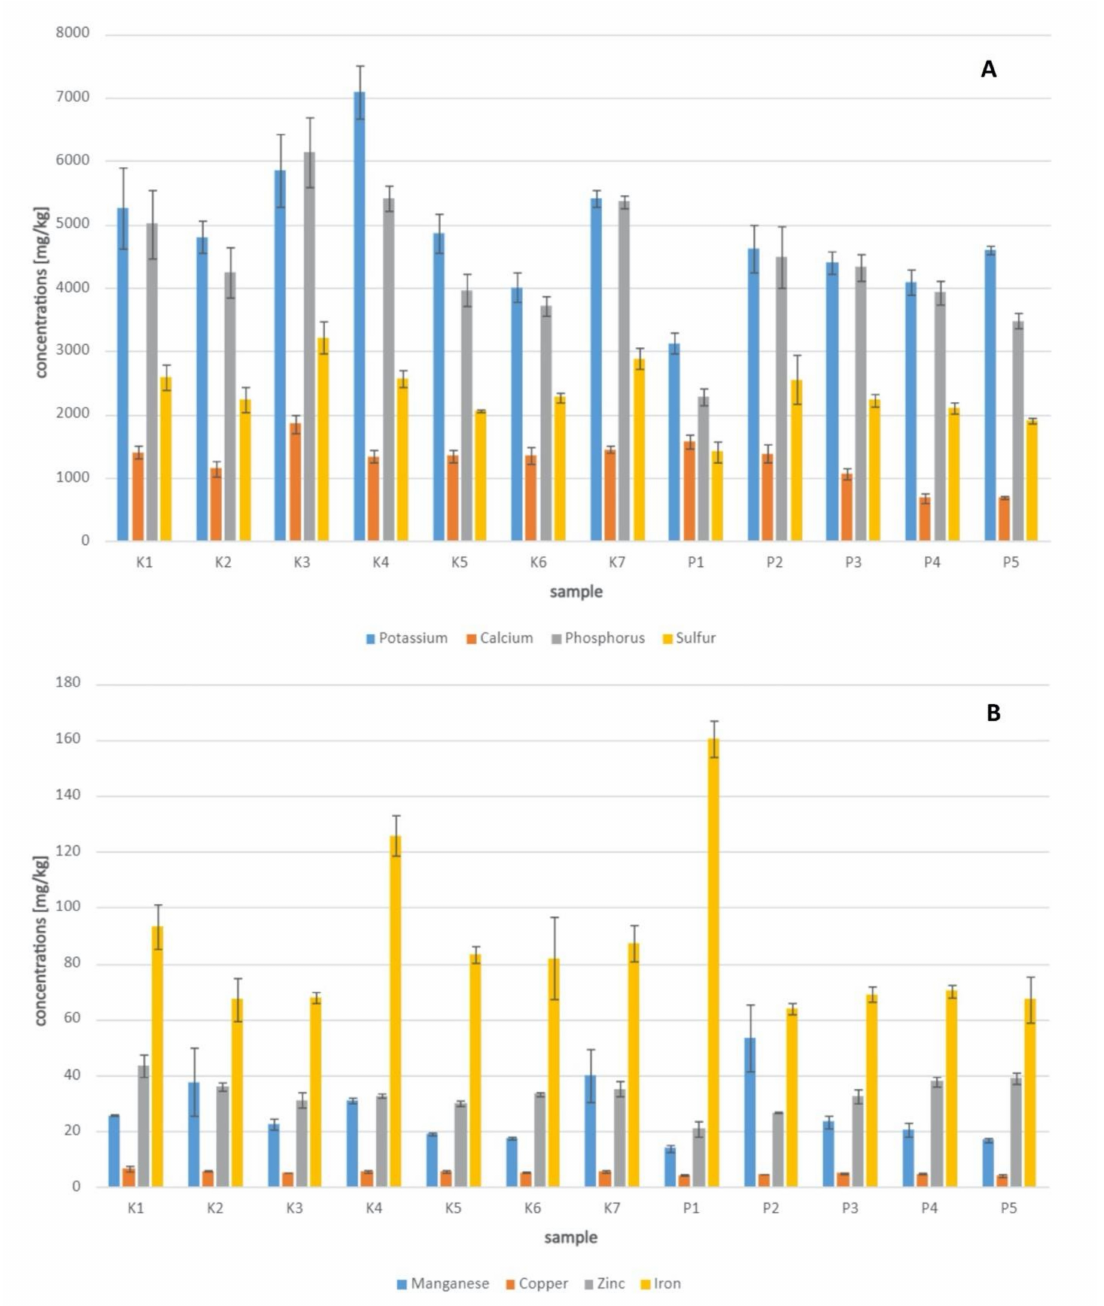
Figure 1. Concentrations of different elements (1. A .: K, Ca, P, S; 1. B .: Mn, Cu, Zn, Fe) measured with the ED-XRF quantitative method (using a standard sample) for bee pollen samples K1–K7 and